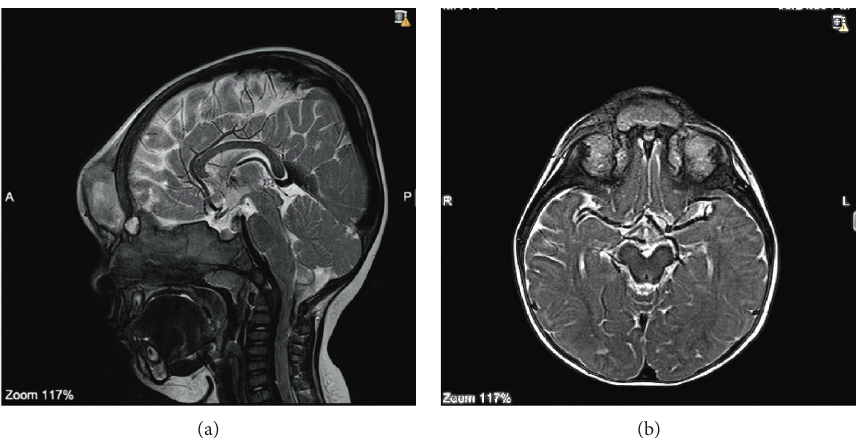
Figure 1: The patient’s brain MRI in the T2-weighted sequence. The intracranial mass connected to the sinus tract and opening into the forehead abscess are shown in a (a) sagittal plane and (b) transverse plane.